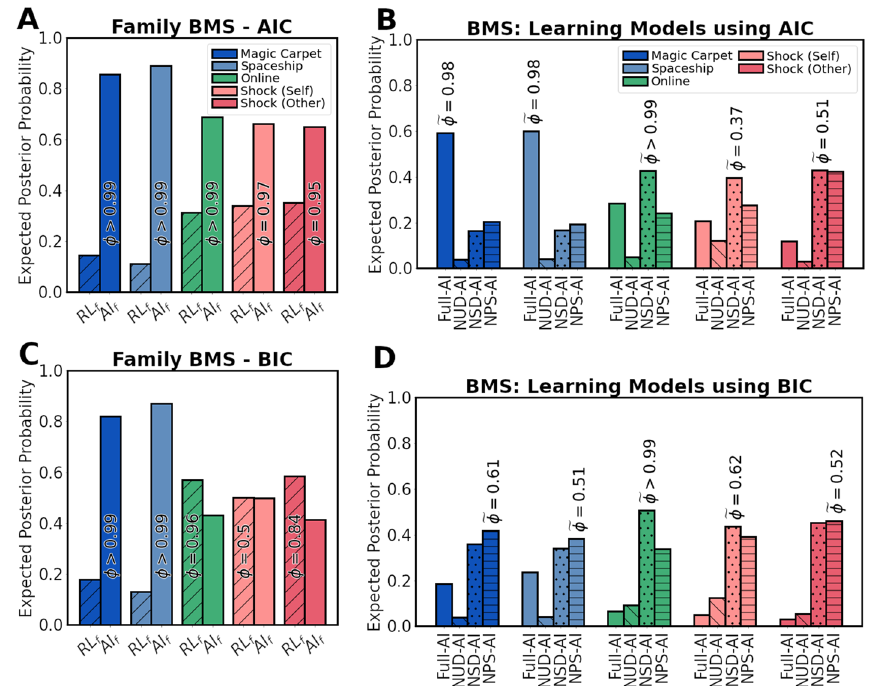
Figure 4. Bayesian model comparison. ( A , C ) Expected posterior probabilities resulting from the Bayesian Model Comparison between the RL f family containing the hybrid-reinforcement learning model and the AI f family, containing the active inference models with varying learning dynamics (see Fig. 2) using AIC ( A ) and BIC ( C ). φ indicates the exceedance probability in favour of the best-scoring family. ( B , D ) Expected posterior probabilities for the different learning models contained within the AI f family. exceedance probability of the best-scoring